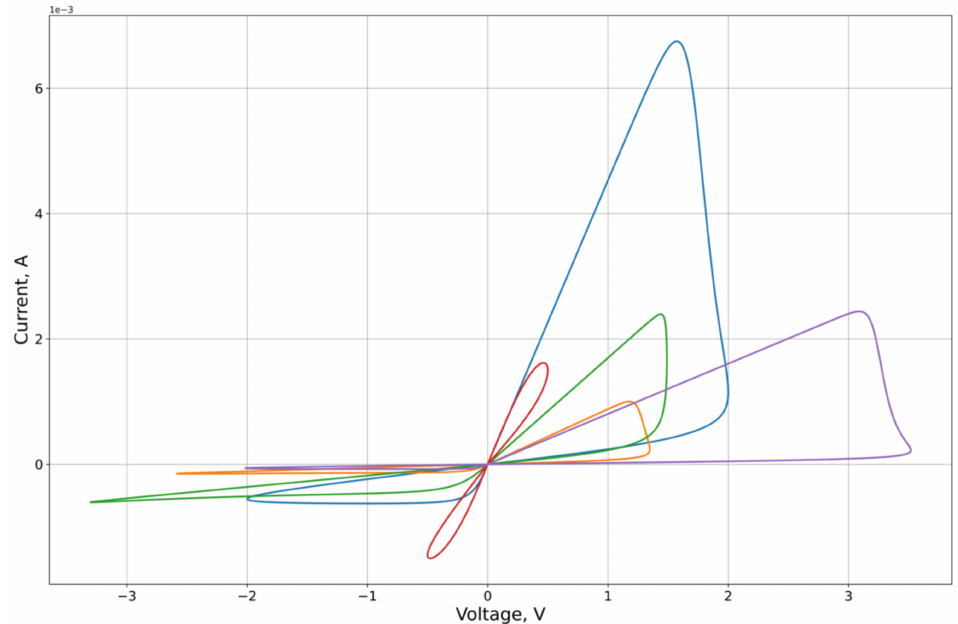
Figure 6. Results of the optimization of the right lobe of the synthetic sampling circuits (Figure 3) by the Zha’s model.